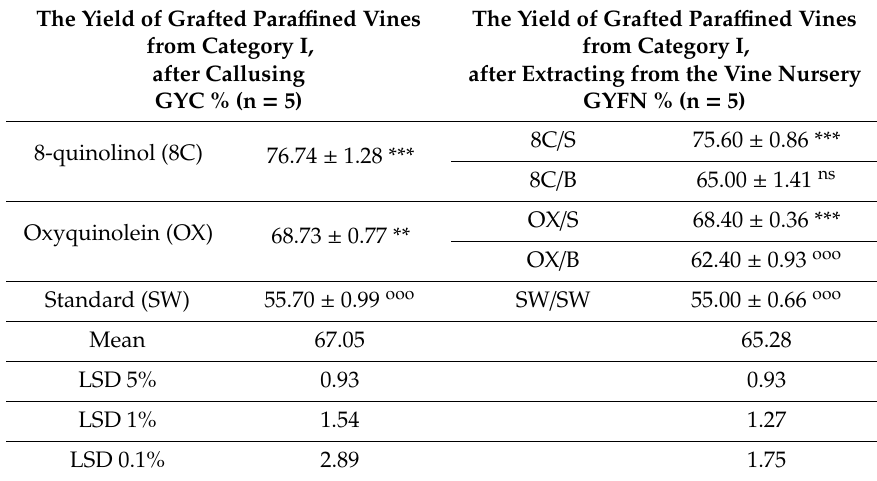
Table 4. Grafts yield after callusing (%) and after nursery uprooting